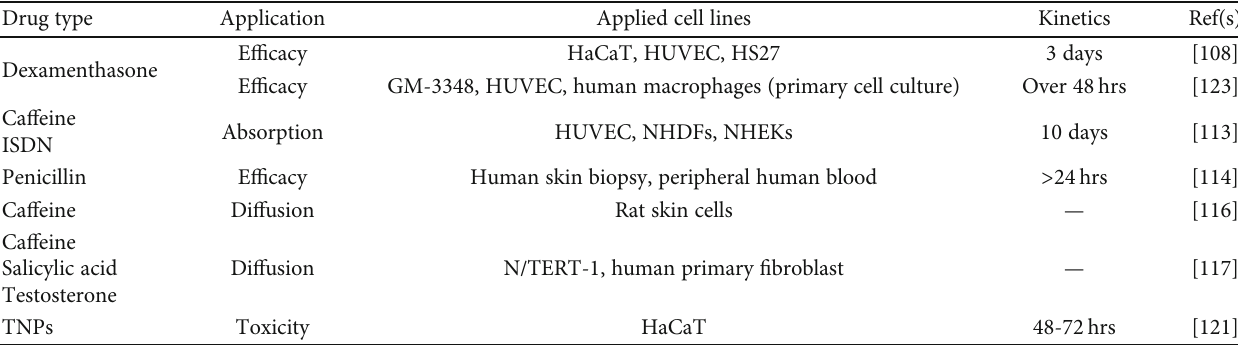
Table 6: Summary of recent advancements in skin-on-chip and drug testing including the type of drug, the application, the applied cell lines, and the kinetics.